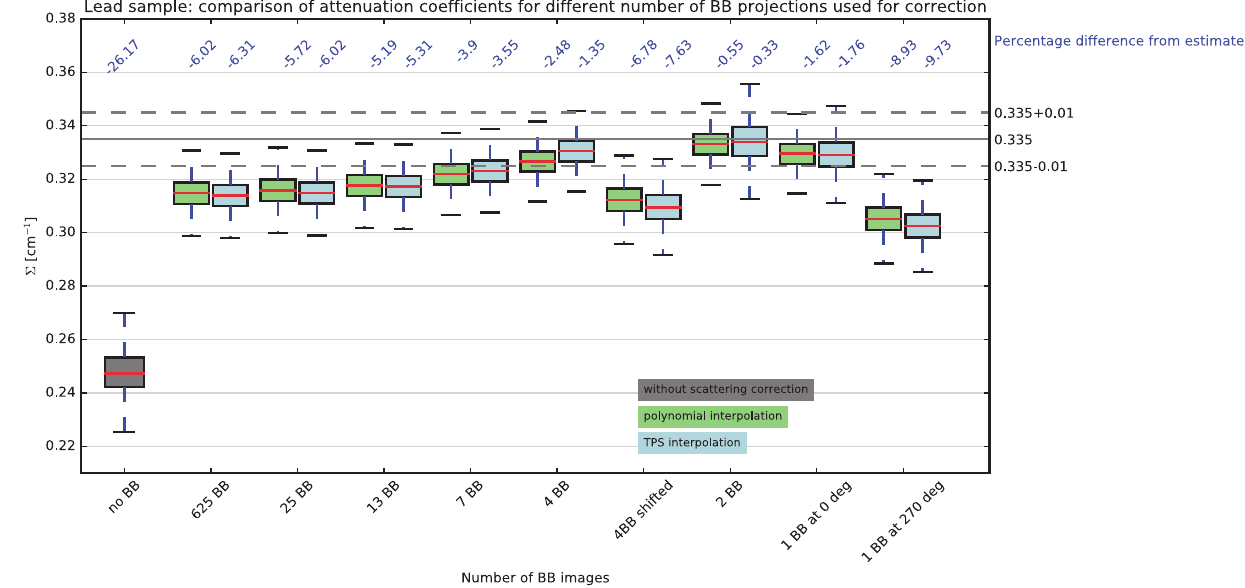
Fig 9. Attenuation coefficients distribution obtained with BB correction for the lead sample, by varying the number of BB images.